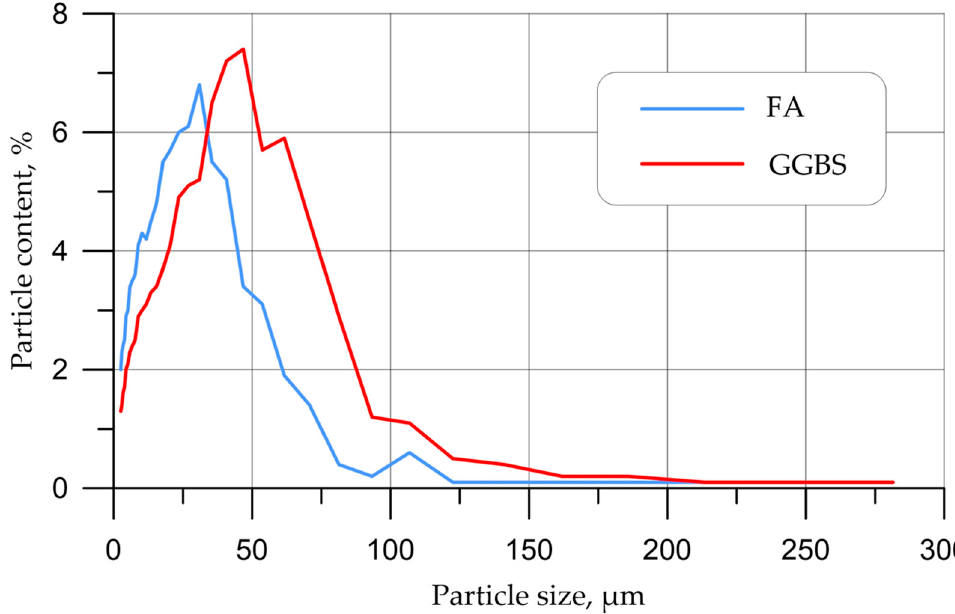
Figure 6. Particle size distribution curves for FA and GGBS after grinding in Activator-4M.